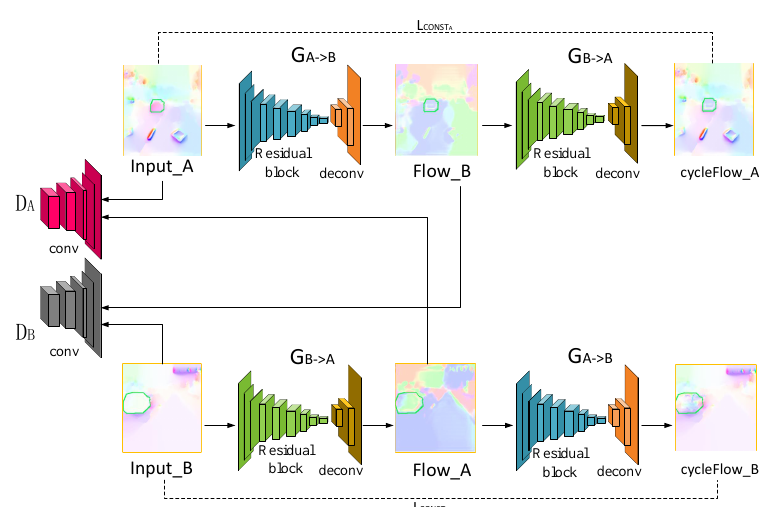
Figure 4. The network structure of